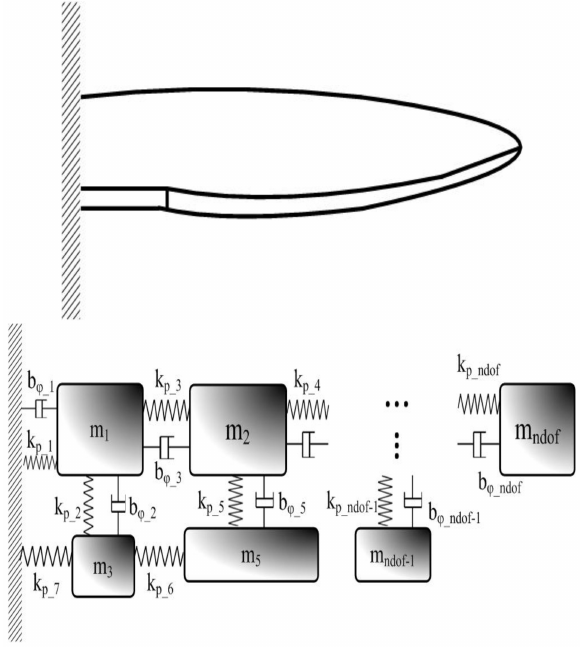
Figure 1. Generic linear/nonlinear vibrating mechanical